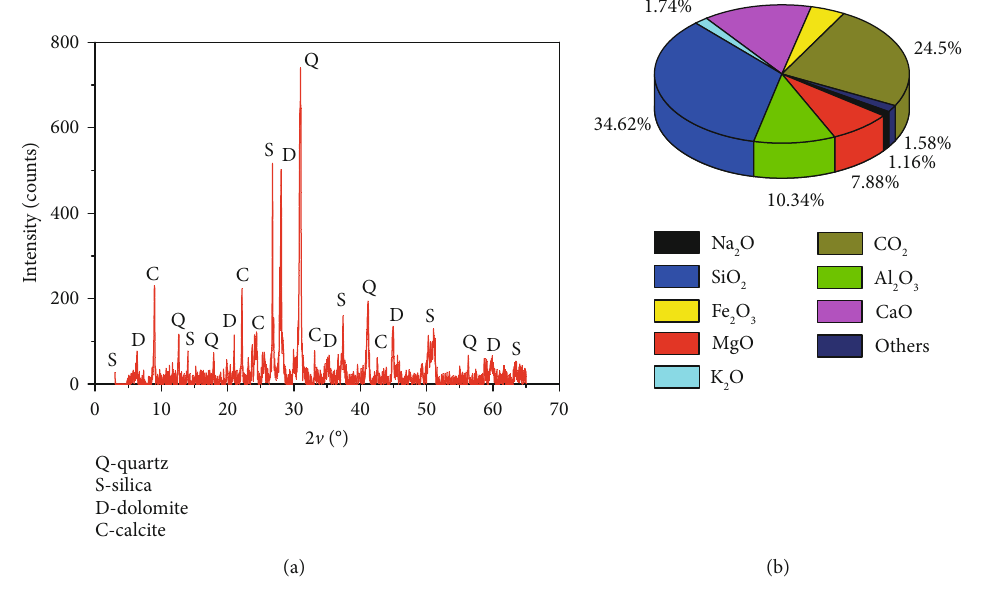
Figure 1: Main components of the tested sandstone: (a) XRD and (b) XRF.